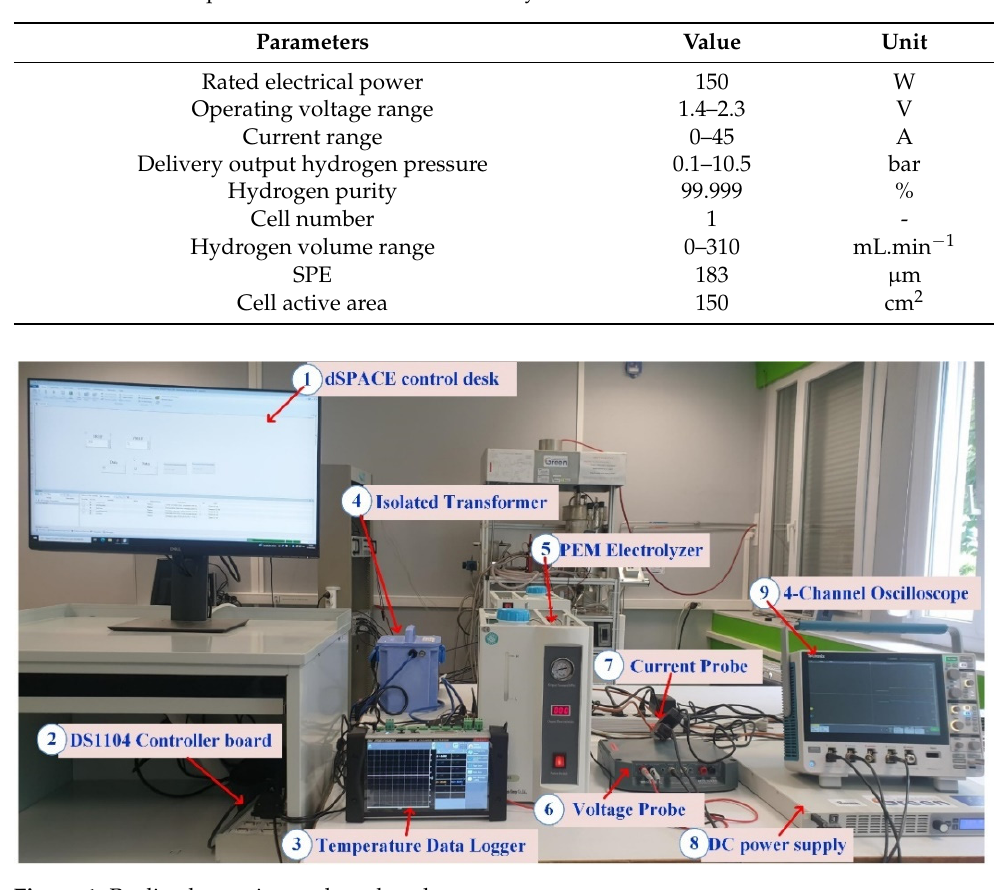
Figure 1. Realized experimental test bench. Table 1. Technical specifications of the PEM electrolyzer.